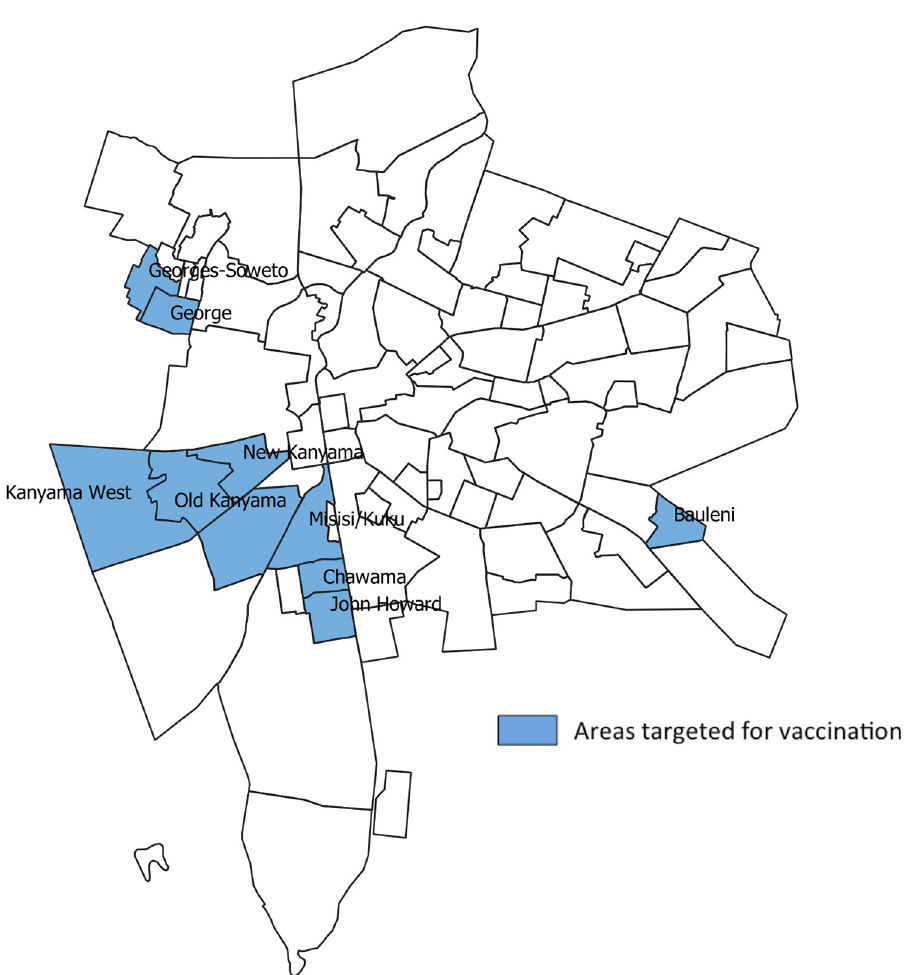
Fig 2. Selected areas for vaccination, Zambia,